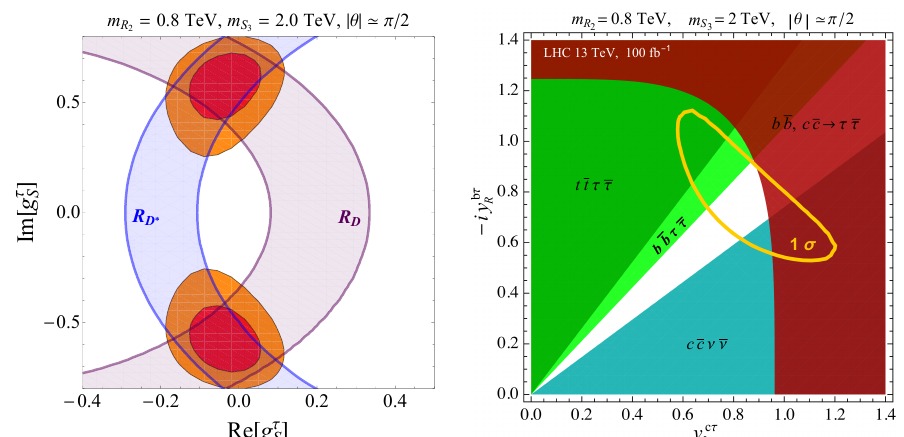
Figure 7: (Left) Results of the flavor fit in the g plane. The allowed 1 σ (2 σ ) regions S L are rendered in red (orange). Separate constraints from R and R at 2 σ accuracy D D ∗ are shown by the blue and purple regions, respectively. (Right) Summary of the LHC exclusion limits (colored regions) for each LQ process at a projected luminosity of = 800 GeV, m = 2 TeV, and | θ | ≈ π/ 2. The region inside the 100 fb − 1 for m R 2 S 3 yellow contour corresponds to the 1 σ fit to the low-energy observables. See text for